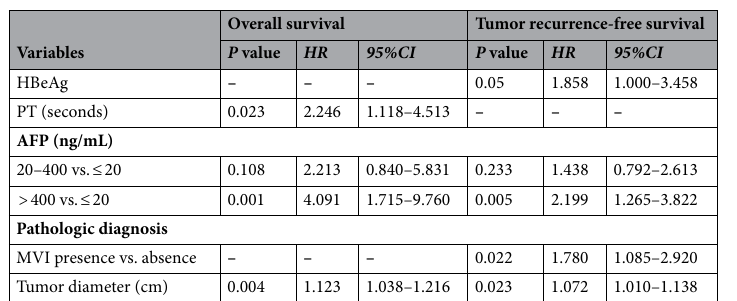
Table 2. Multivariate Cox regression analysis for overall survival and tumor recurrence-free survival of HCC patients. HbeAg hepatitis B e antigen, PT prothrombin time, AFP